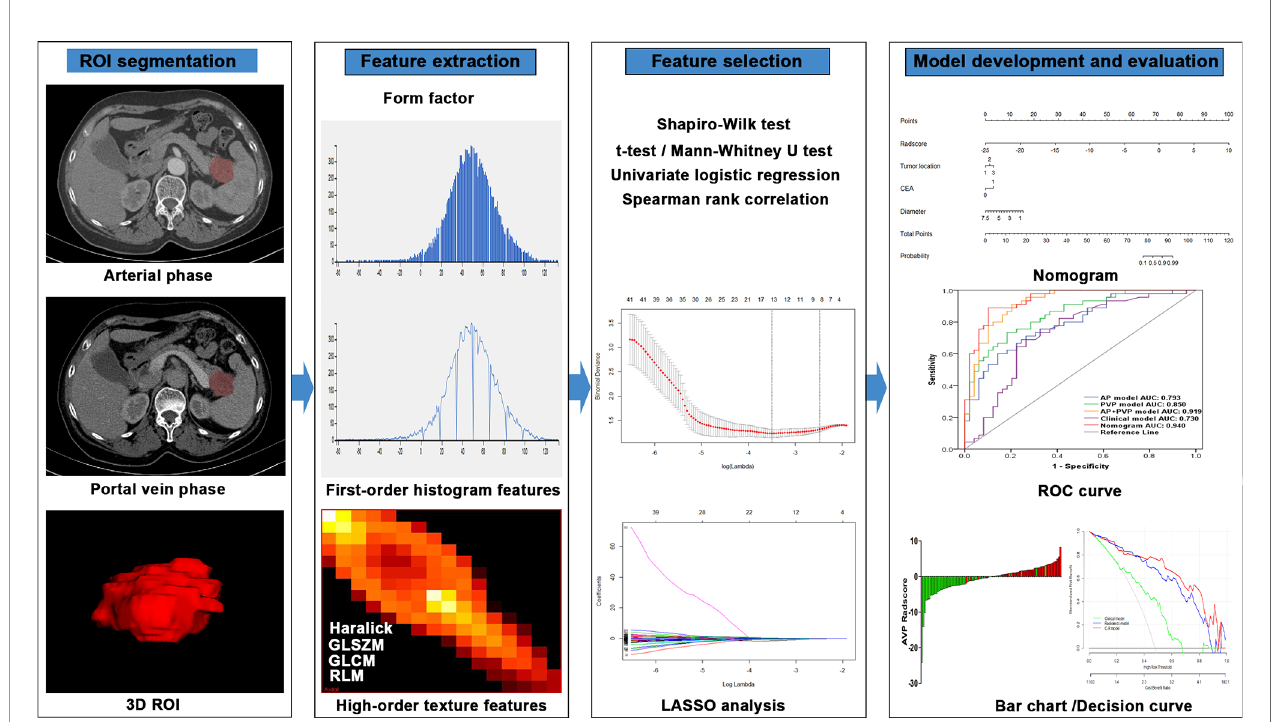
FIGURE 2 | Flowchart of the radiomics method for PDAC stage prediction. LASSO, least absolute shrinkage and selection operator; ROC, receiver operating